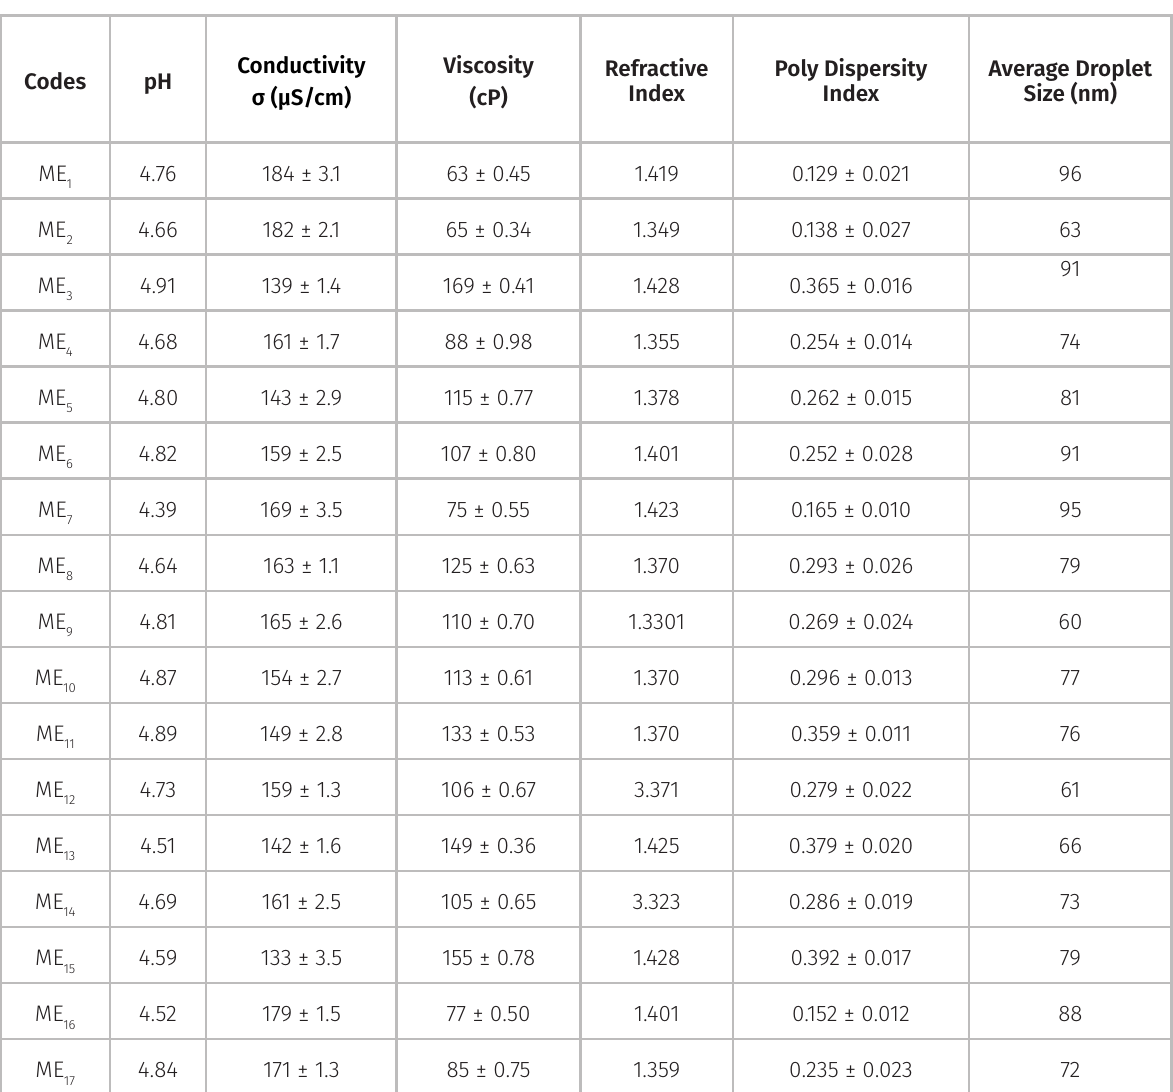
Table II. Characterization of MEs.